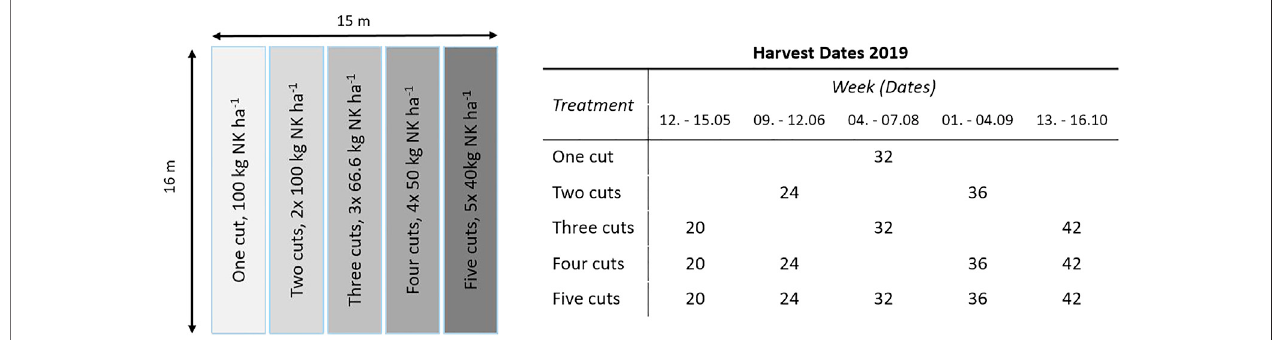
FIGURE2| Exemplarysplit-plotdistributioninonemainplot,indicatingnumberofannualcutsandcorrespondingfertilizationrates.Thedistributionofsubplotshas been randomized on each main plot. Harvest weeks and dates are given for the corresponding treatments and harvest occurrences.